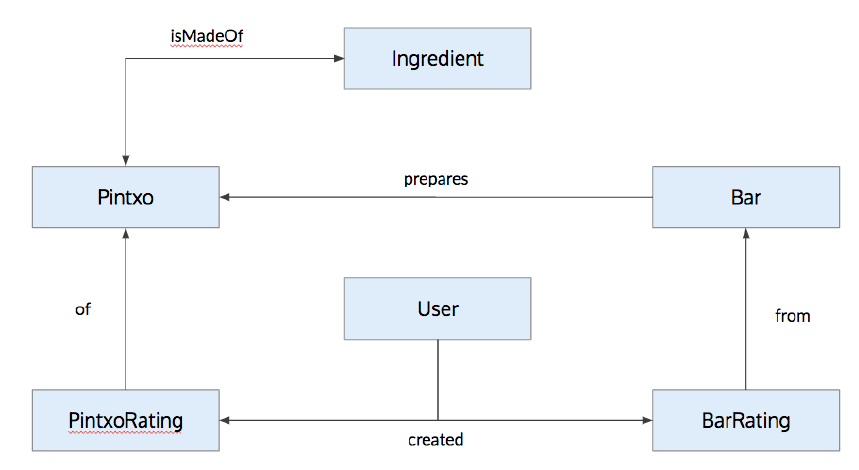
Figure 1. Diagram for foodbar data